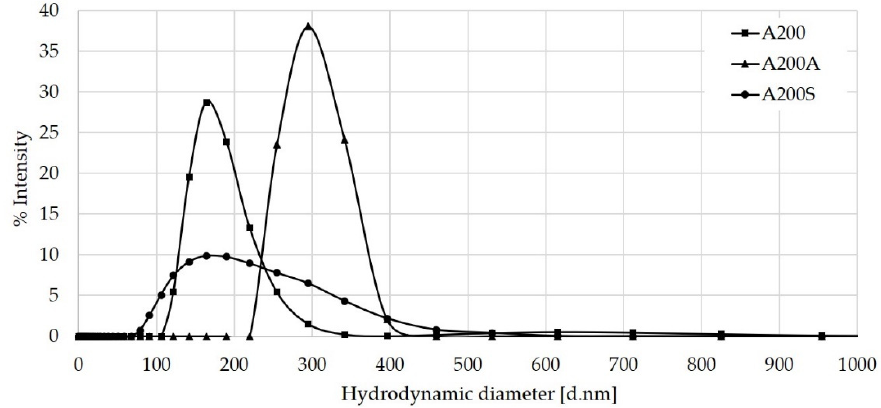
Figure 11. DLS results of A200, A200A, and A200S NPs.